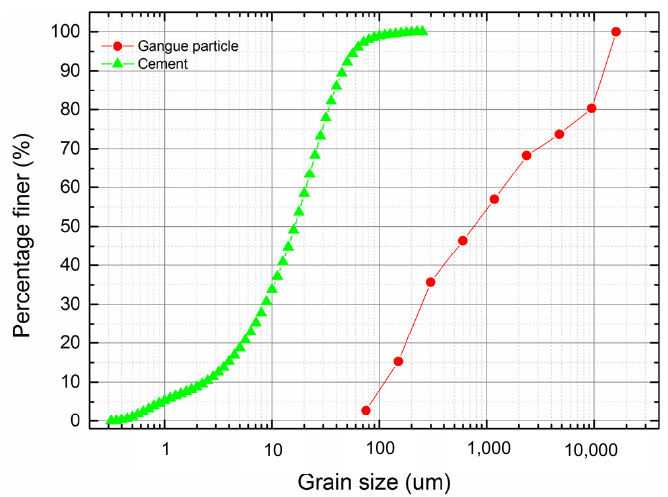
Figure 1. The distribution of the particles of filling materials.